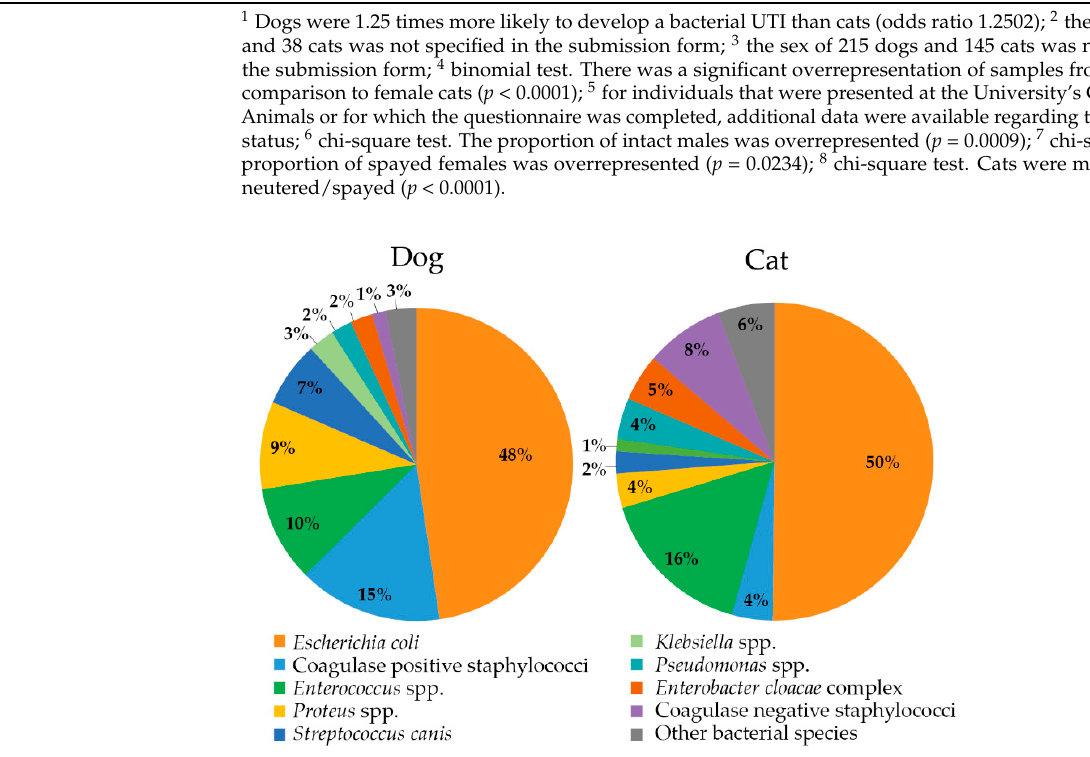
Figure 1. Prevalence of bacterial species recovered from the urinary tract of dogs ( n = 697 isolates) and cats ( n = 313 isolates). Other species: Acinetobacter spp., Aerococcus viridans , Alcaligenes faecalis, Citrobacter freundii, Corynebacterium spp., Leclercia adecarboxylata , Morganella morganii , Pasteurella spp., Providencia stuartii, Pseudescherichia vulneris , Rahnella spp., Raoultella planticola , Serratia marcescens , and Stenotrophomonas spp.